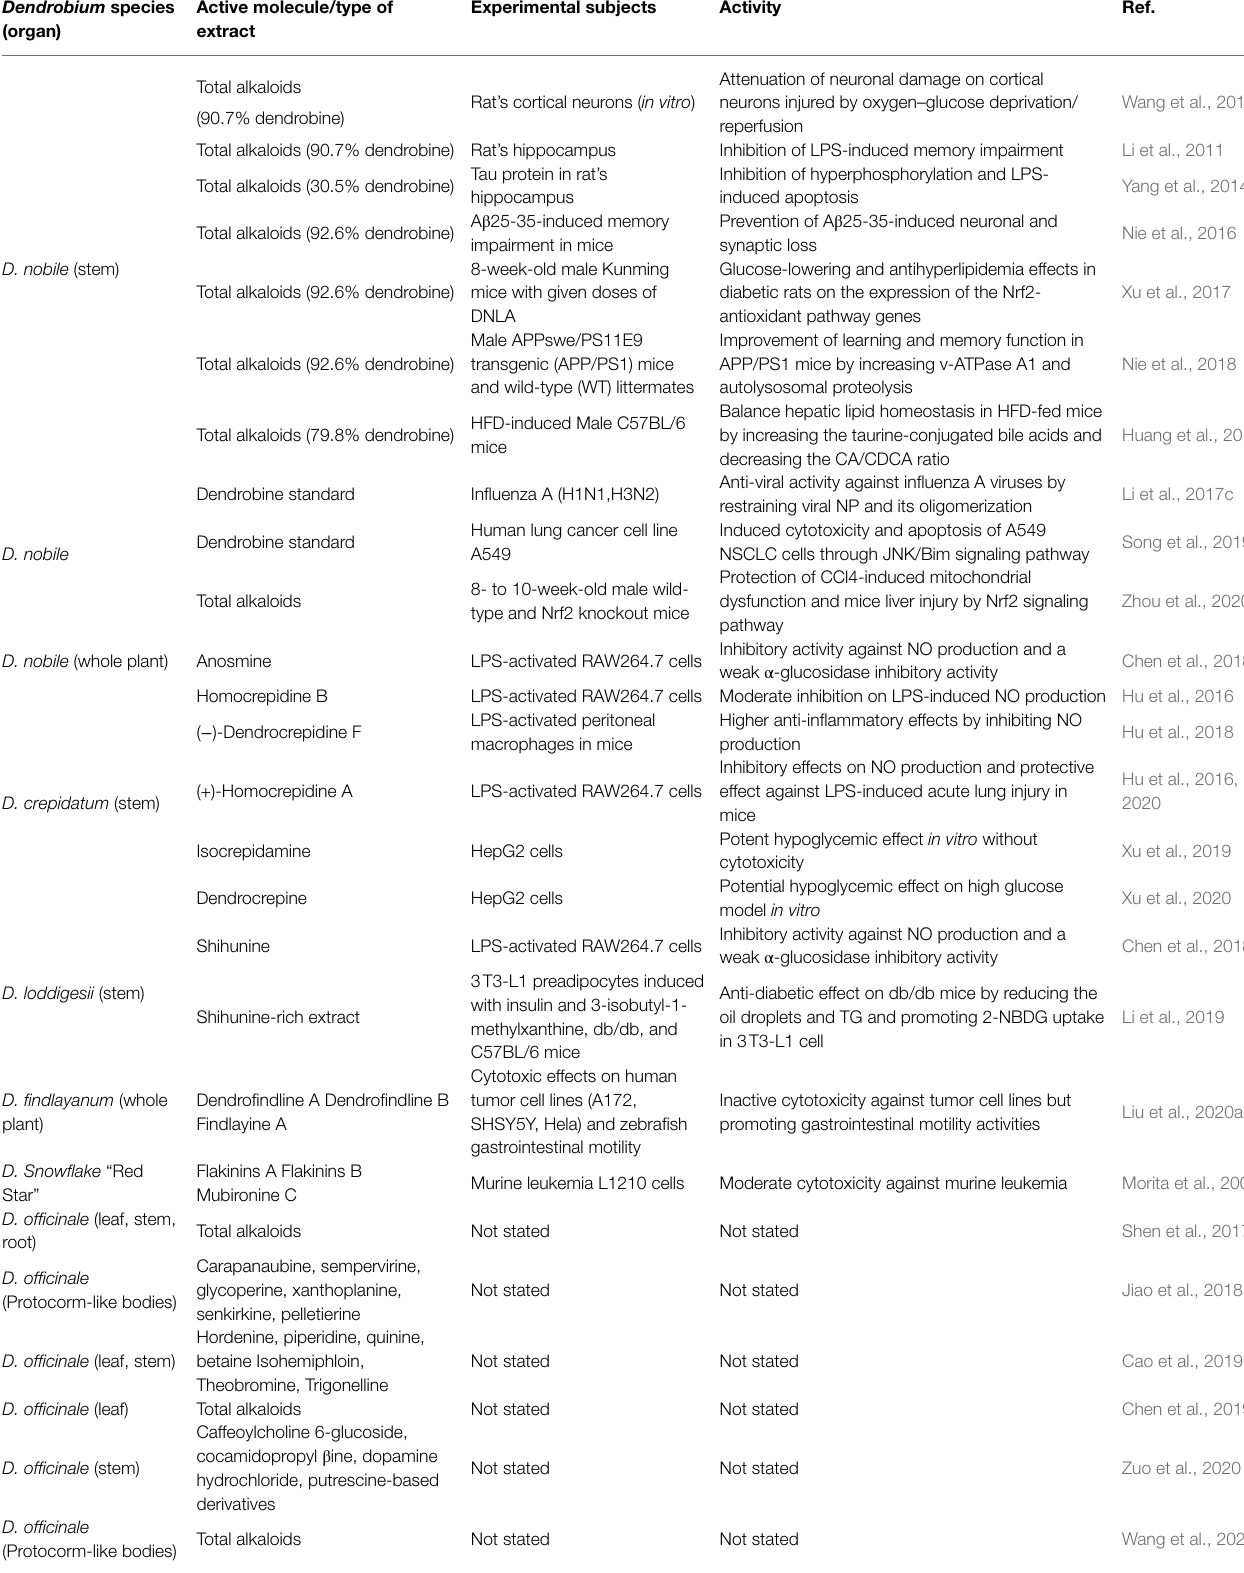
TABLE 1 | Dendrobium spp. and alkaloid constituents with biological properties. Dendrobium species Active molecule/type of (organ)